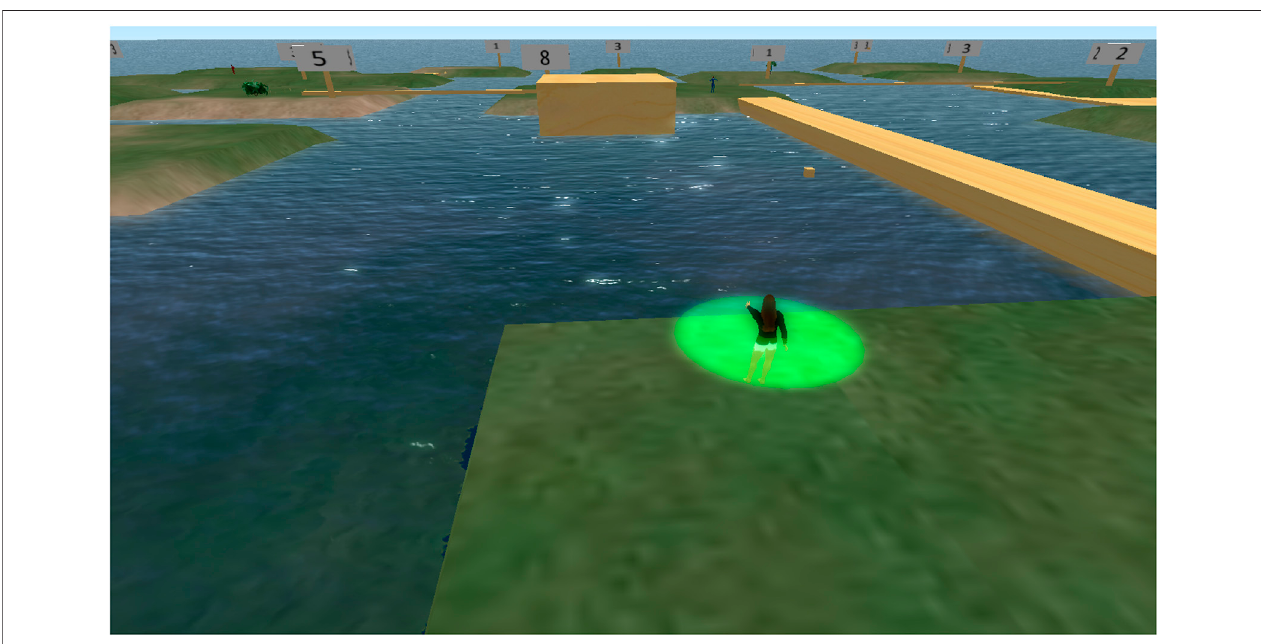
FIGURE 4 | SORBET environment from the perspective of one avatar.